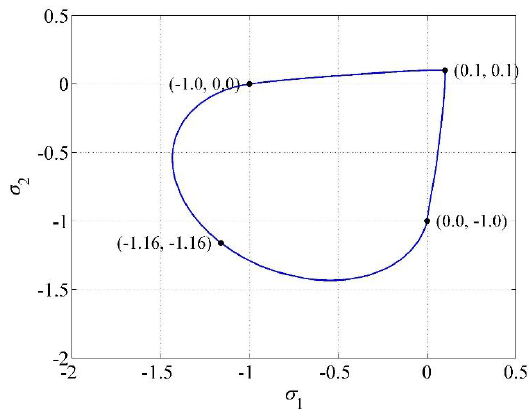
Figure 8. Trace of the three-parameter Willam–Warnke yield surface in the 𝜎 1 - 𝜎 2 plane for 𝑓̅ 𝑡 = 0.1 and 𝑓̅ 𝑏𝑐′ = 1.16 .